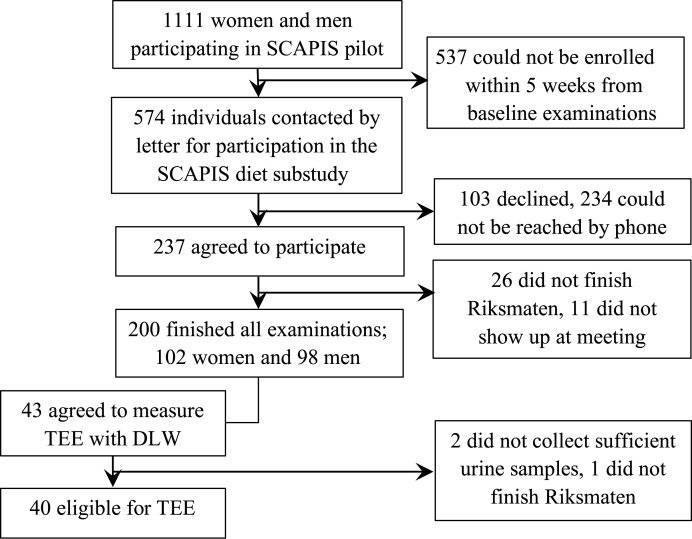
Flow chart of recruitment of participants to the Swedish CArdioPulmonary bioImage Study (SCAPIS) diet substudy. TEE, total energy expenditure; DLW, doubly labelled water.